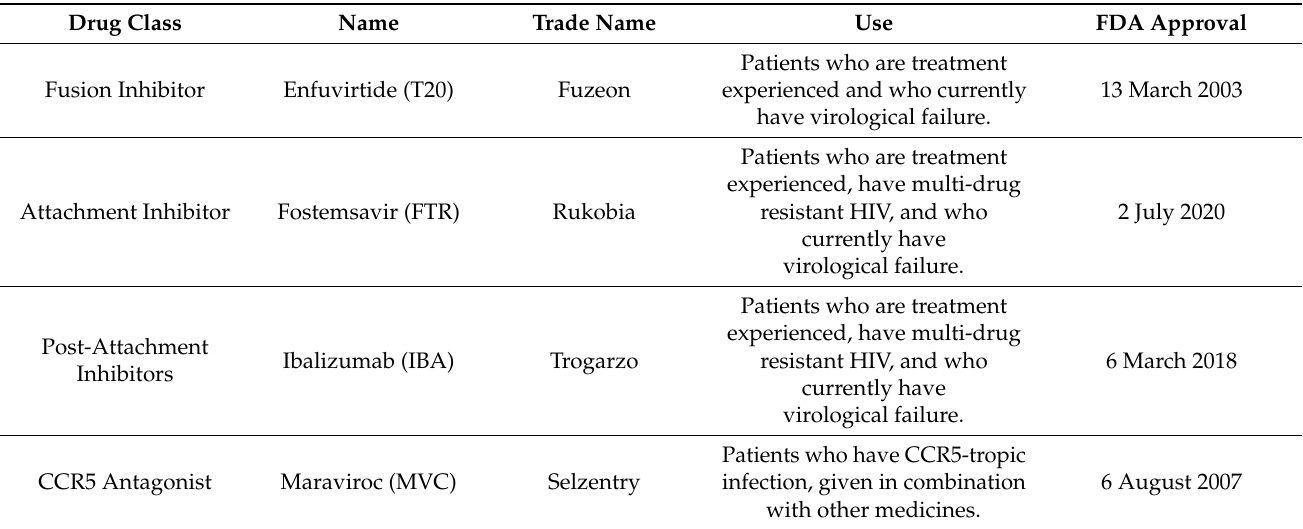
Table 1. Attachment and entry